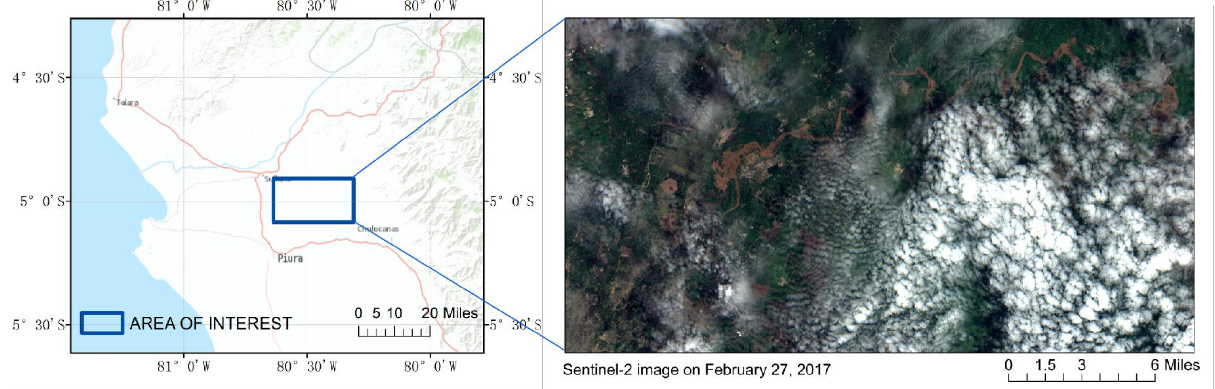
Figure 1 . Study area in Peru.